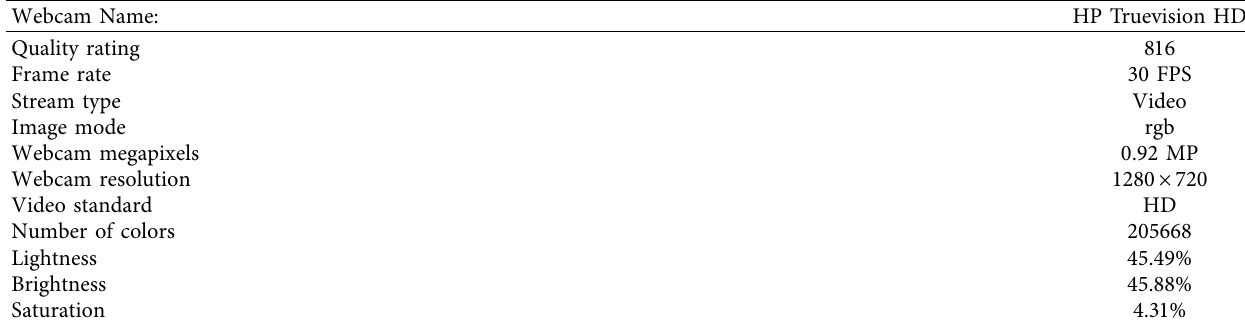
Table 1: Webcam object-specific